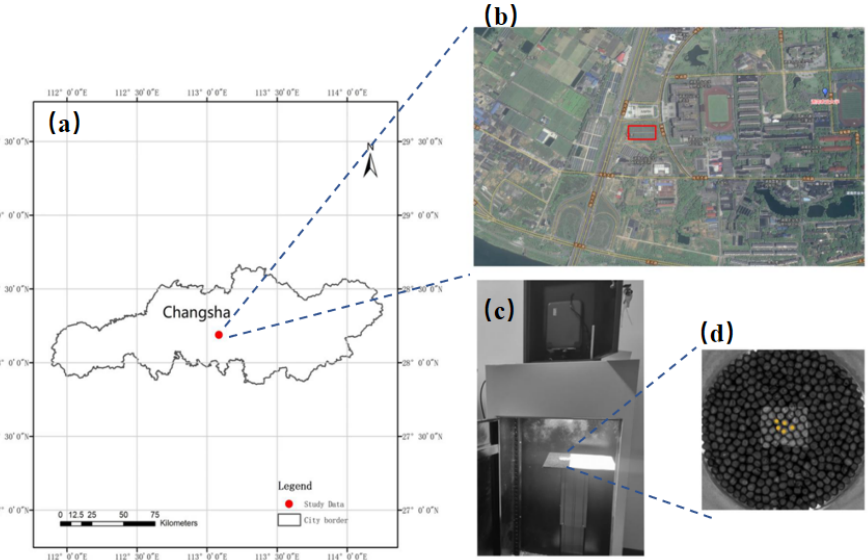
Figure 1. Location of the study area and hyperspectral collection environment. ( a ) Location of the study area in Changsha of China; ( b ) satellite map of Hunan Agricultural University Yunyuan Experimental Base (the red box); ( c ) the aneroid of hyperspectral data acquisition; ( d ) ROI of rapeseed sample.